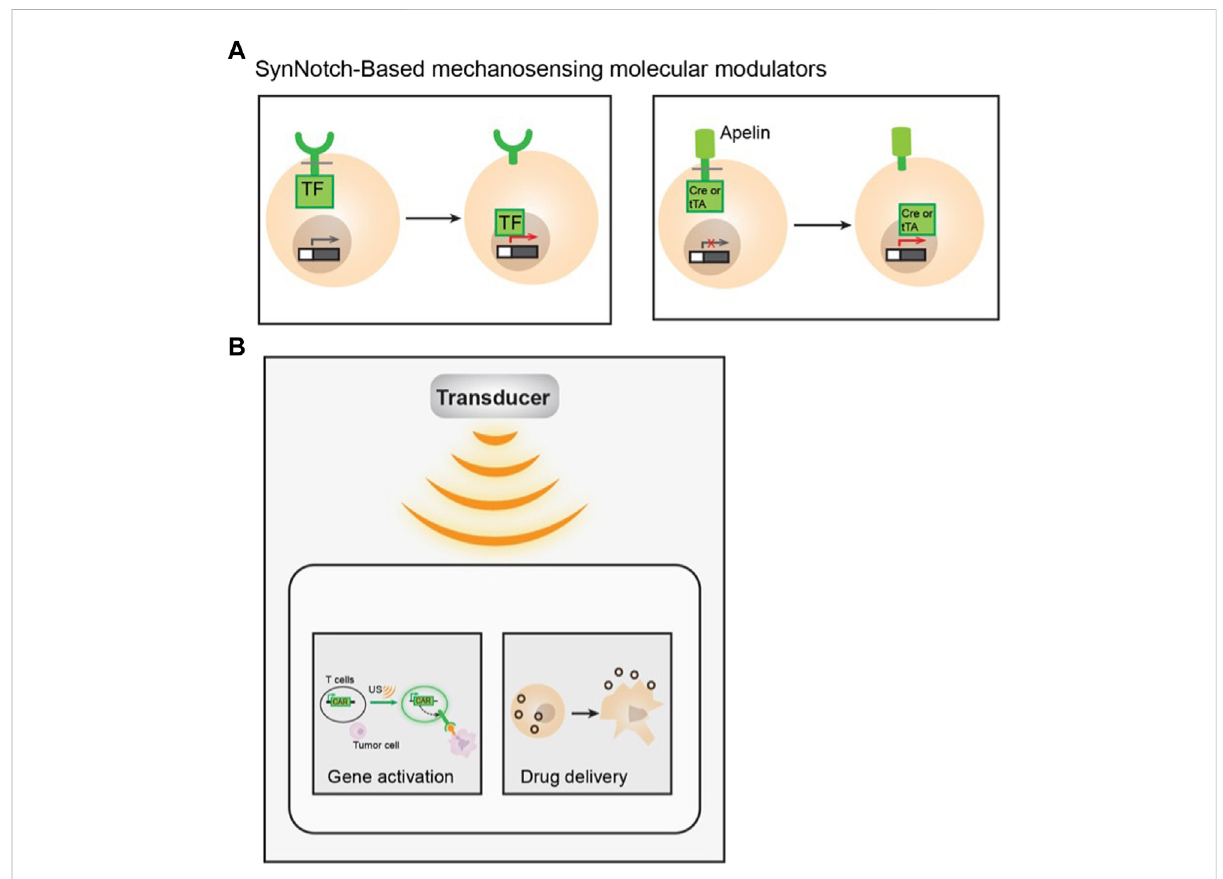
FIGURE 4 Examples of applying mechanobiology for immuno-engineering. (A) Examples of SynNotch based mechanosensing molecular modulators. Antigen speci fi csyntheticnotchreceptorsweretagged with atranscription factor(TF)intracellularly. Itsactivation canleadto gene expression upon antigen binding, via the subsequence release of TF upon cleavage (left). An apelin based SynNotch receptor tethered to a Cre or tTA recombinase intracellularly. Upon apelin-APJ interaction, the cleavage will release the recombinase and activate the designed gene of interest (right). (B) Schematic showing of ultrasound activation of engineered immune cells, Ultrasound can activate mechanosensitive ion channel expressing T cell and trigger gene activation through designed genetic circuits to speci fi cally kill antigen expressing tumor cells (left). Macrophages were engineered withultrasound-responsivecomponentsandthepayload.Uponshort-pulsedhighintensityfocusedultrasound(HIFU)sonication,themacrophages can be disrupted, which allows drug release into the tumor locus